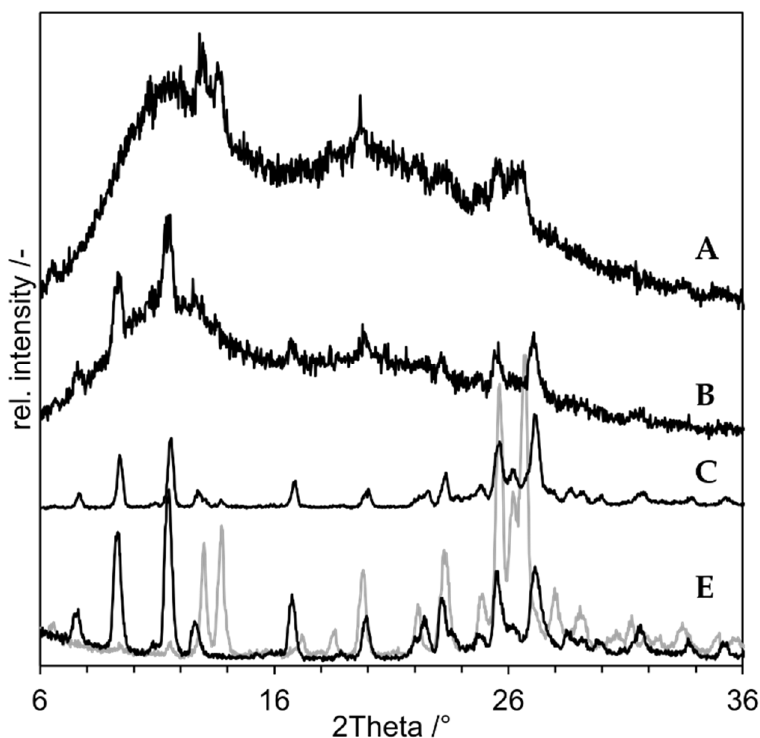
Figure 10. X-ray diffractograms of Dry-Melting experiments with microsuspension containing niclosamide monohydrate. (A) Suspension dried at 220 ◦ C, (B) Suspension dried at 120 ◦ C, (C) Suspension dried at room temperature, (E) Niclosamide anhydrate (grey), Niclosamide monohydrate (black).